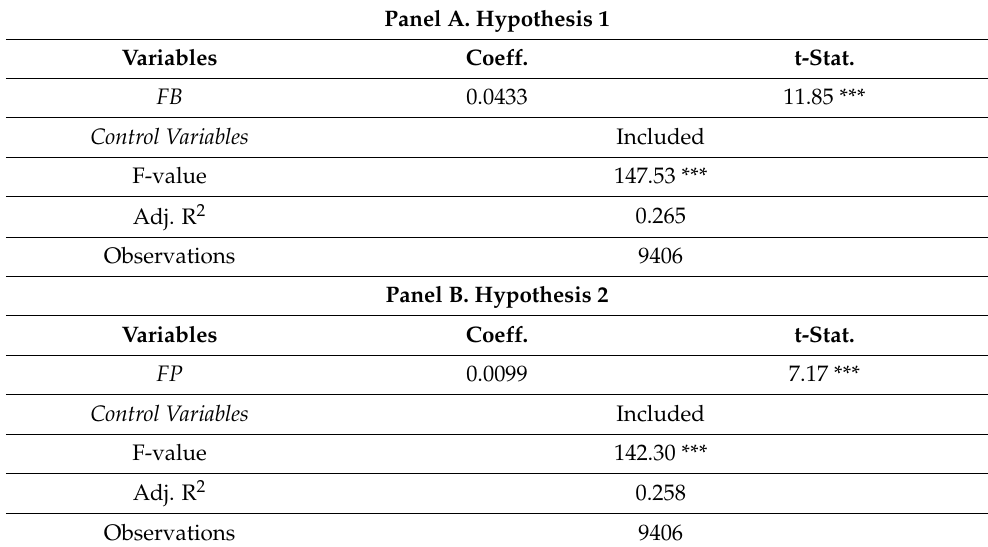
Table 7. Robustness